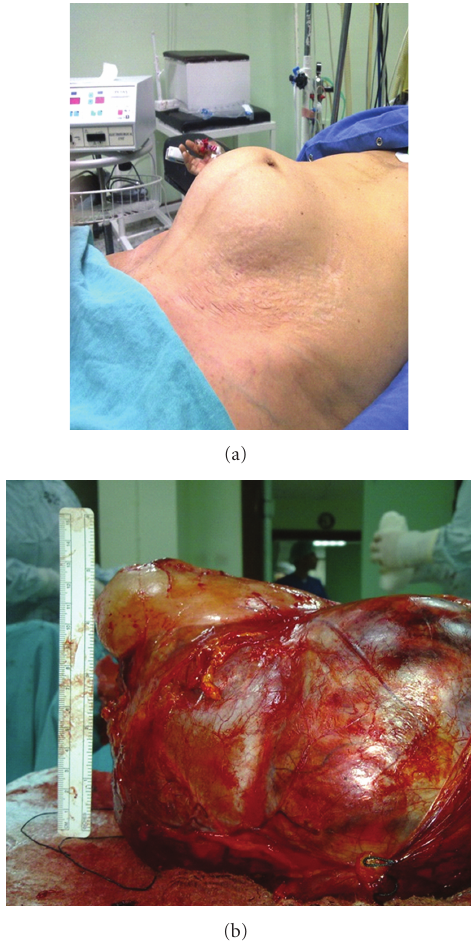
Figure 1: Histologic examination of tumoral tissues composed of solid cellular conglomerates of monomorphic spindle cells with nonuniformly bounded cytoplasm in large areas and fascicles with cystic structures settled among them.